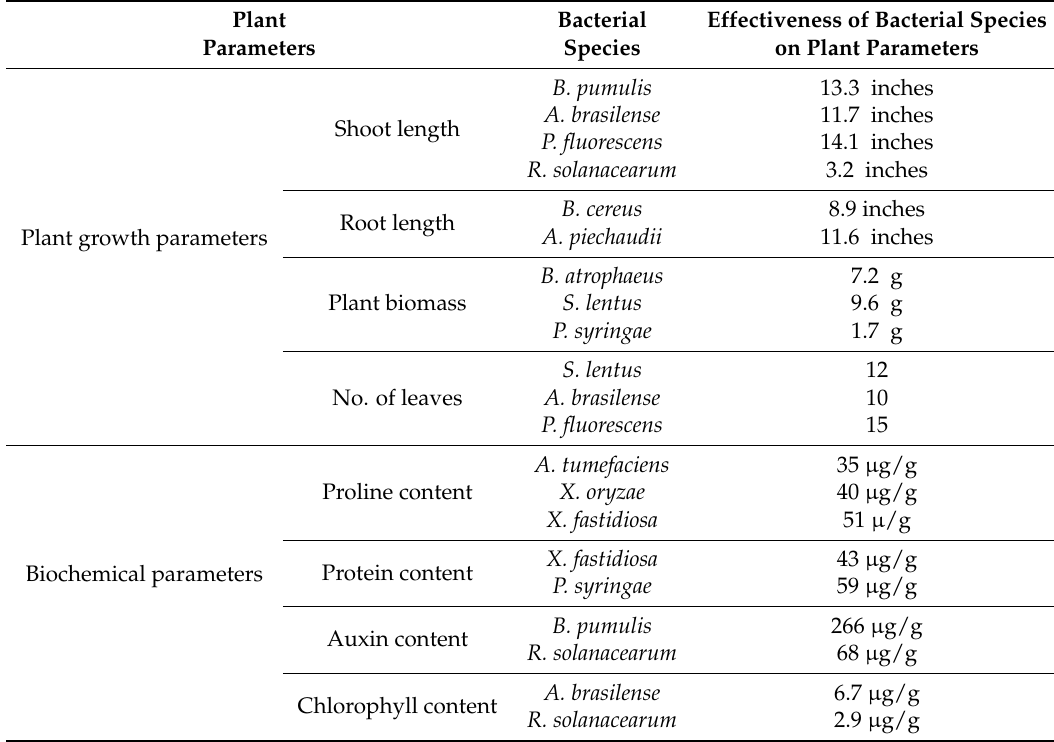
Figure 5.1: Potential role of plant-associated bacteria in soil ecosystem Figure 17. Potential role of plant-associated bacteria in soil ecosystem. Table 2. Impact of Bacterial Species on Plant